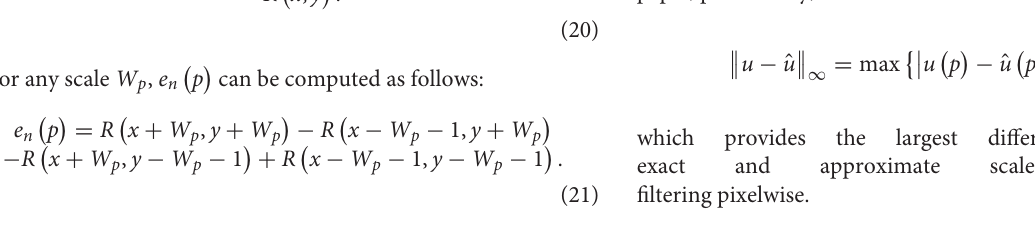
exact and approximate scale-adaptive bilateral filtering